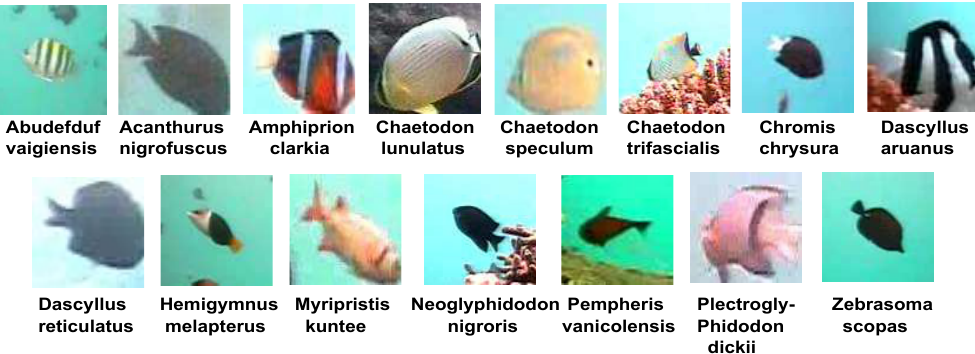
Figure 7. Sample images of 15 fish species in the LCF-15